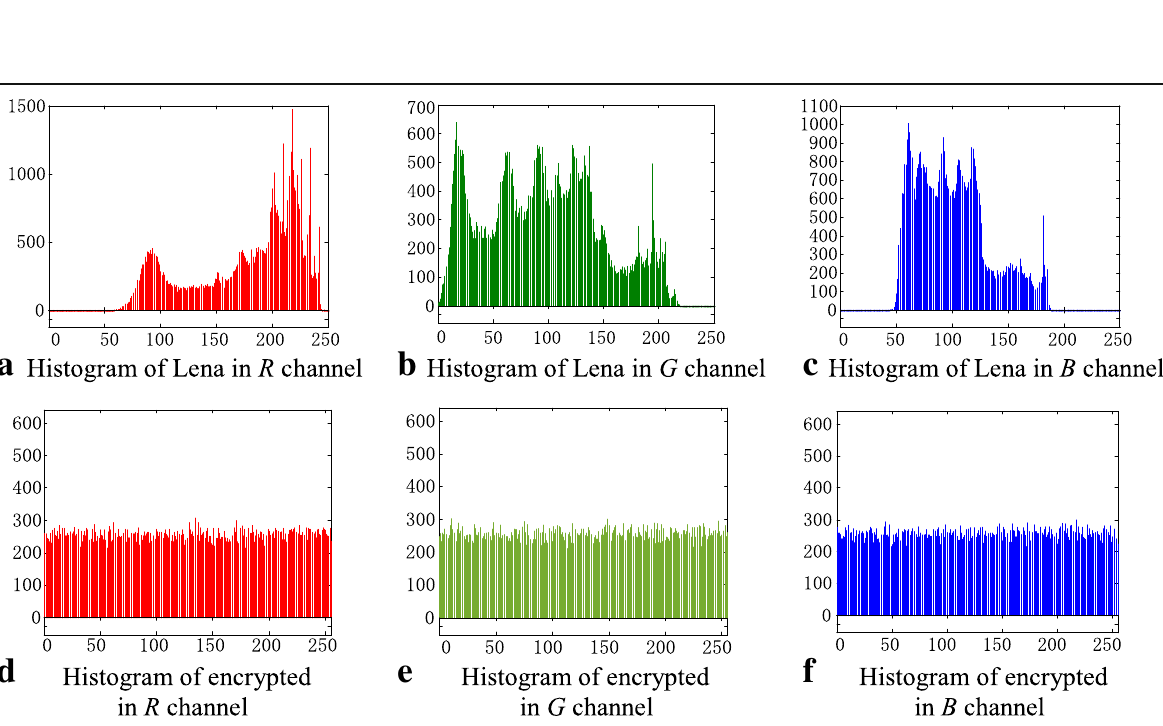
Fig. 5 Histogram of the color Lena image and cipher image. a Histogram of Lena in R channel; b histogram of Lena in G channel; c histogram of Lena in B channel; d histogram of encrypted in R channel; e histogram of encrypted in G channel; f histogram of encrypted in B